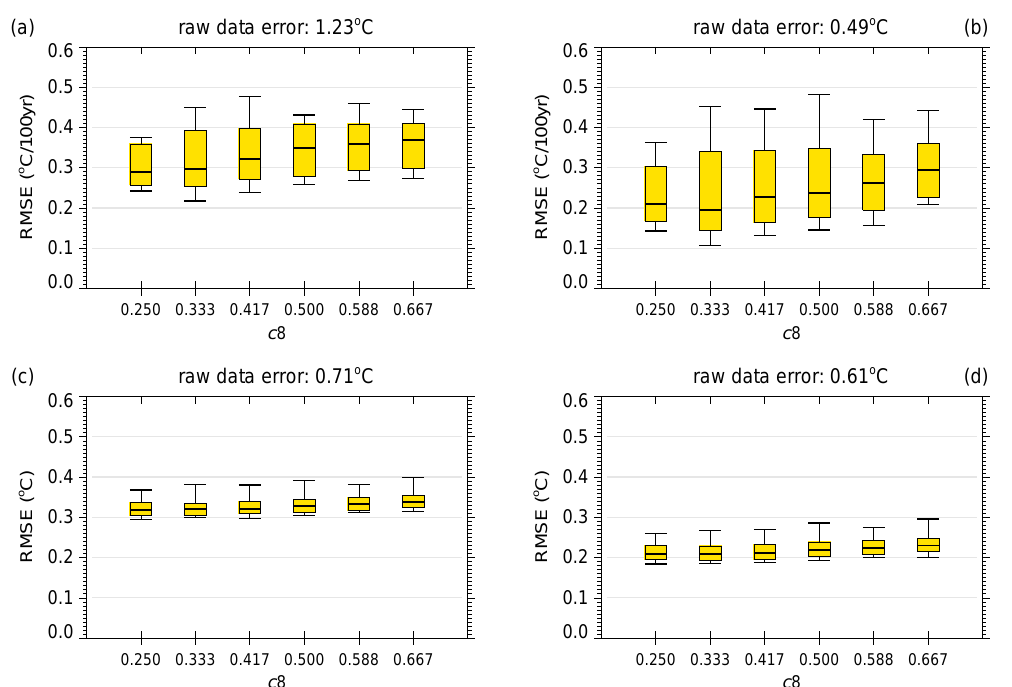
Figure 1. The sensitivity of residual errors to parameter c 8. (a) Trend bias of station series, (b) trend bias of network-mean series, (c) RMSE of monthly values, (d) RMSE of annual